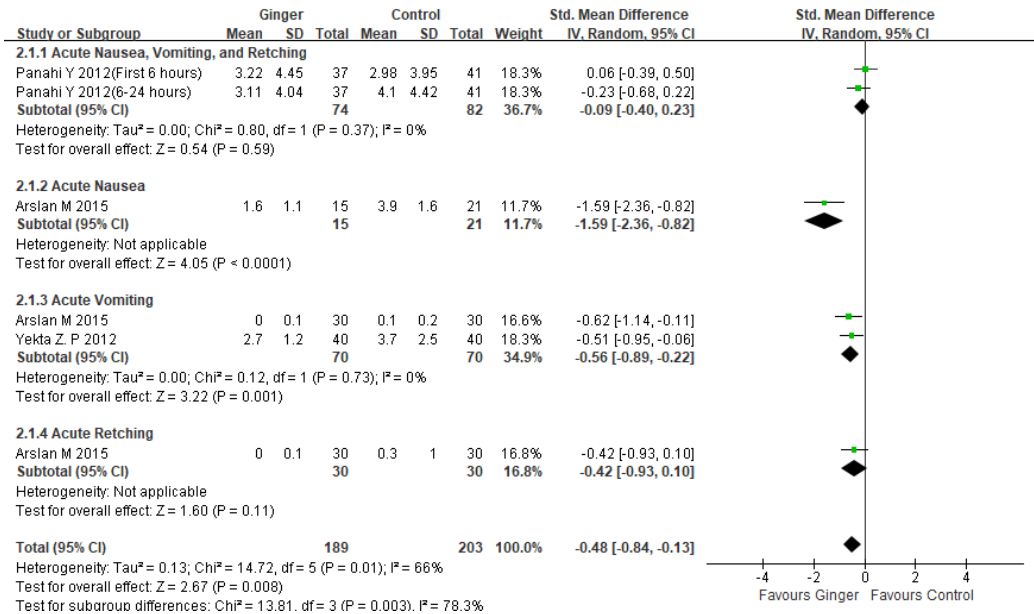
Figure 3. Forest plot of acute CINV severity managements in ginger intake versus controls. CI: confidence interval; SD: standard deviation [24–26].